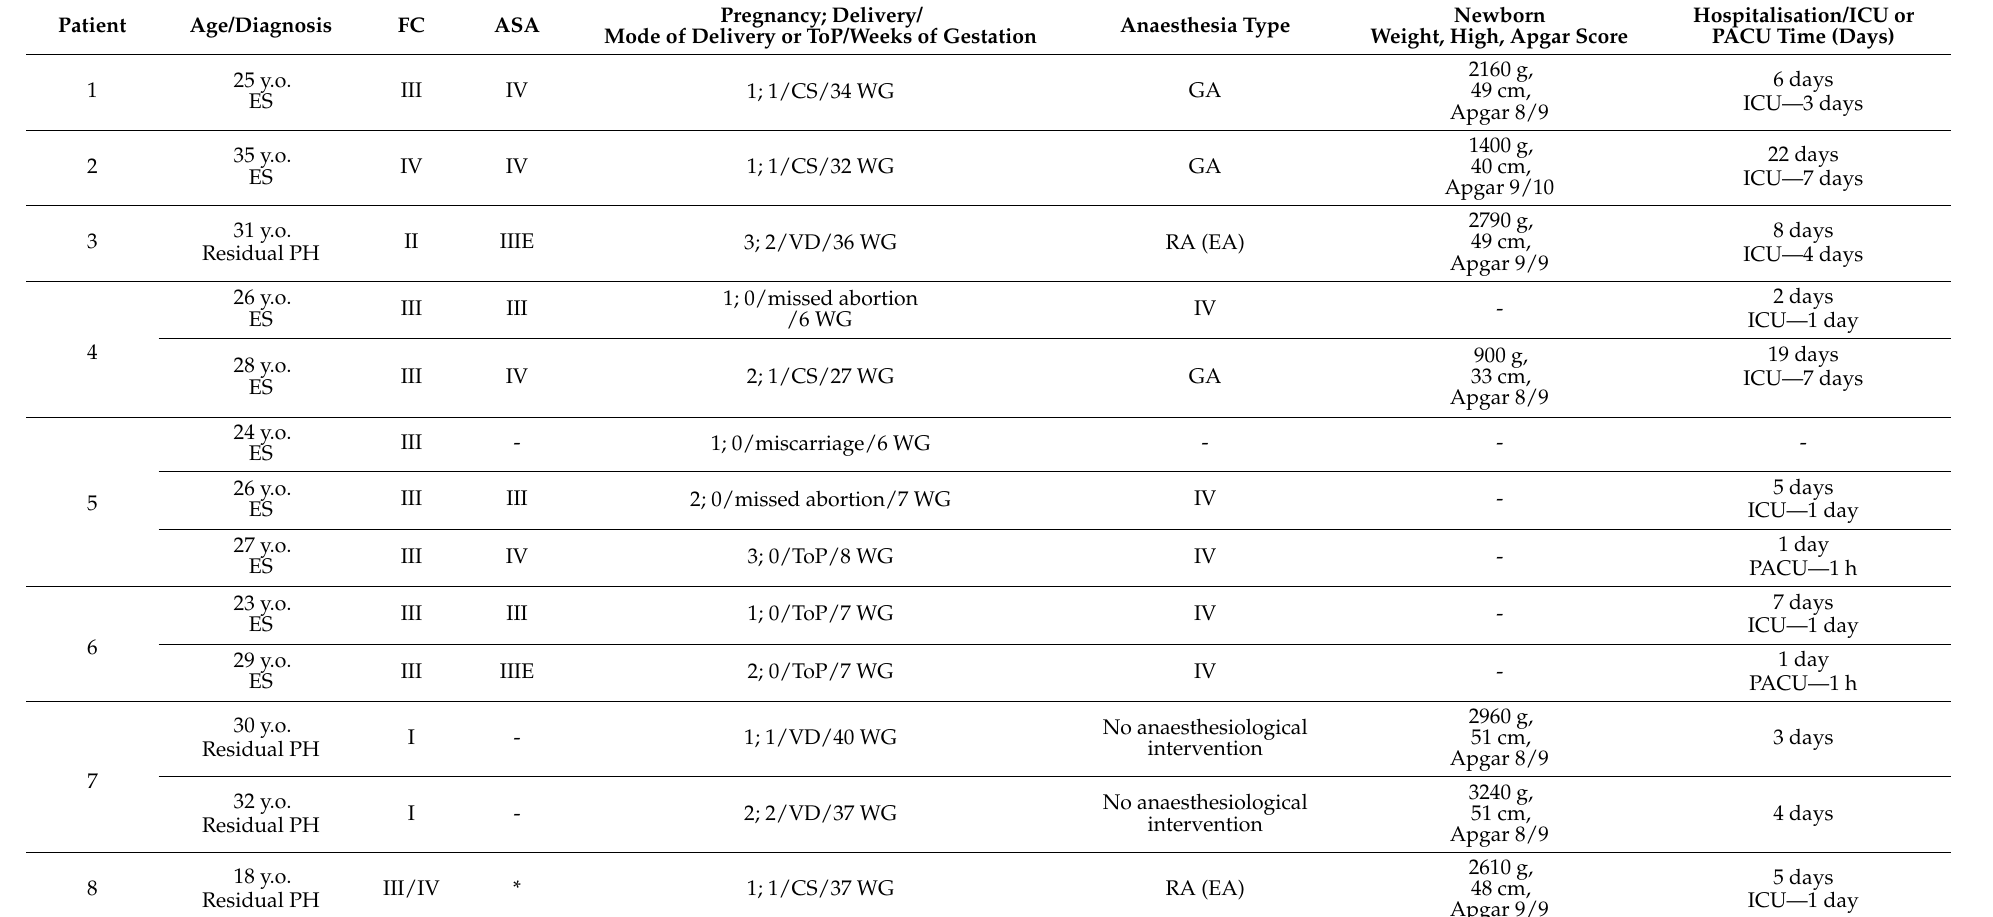
Table 2. The basic characteristic of pregnancy outcomes, delivery, and in-hospital